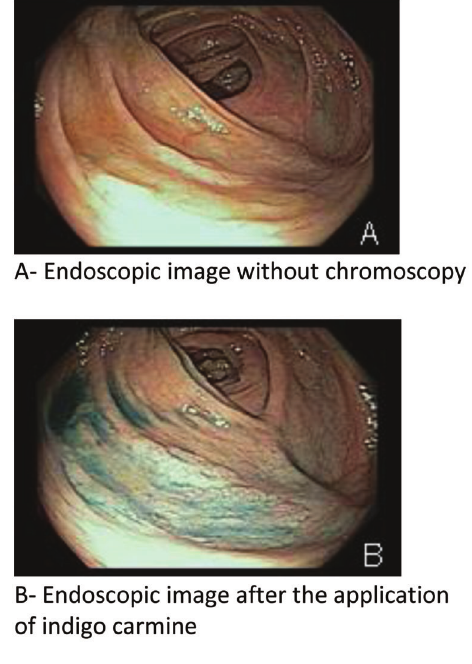
Figure 2 - Serrated adenoma in the ascending